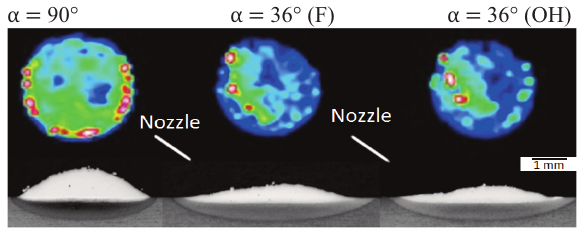
Fig. 8. Temperature distribution of the melt pool (“ E-MAqS ” visualization) and the cladding profile at α = 36° and α =